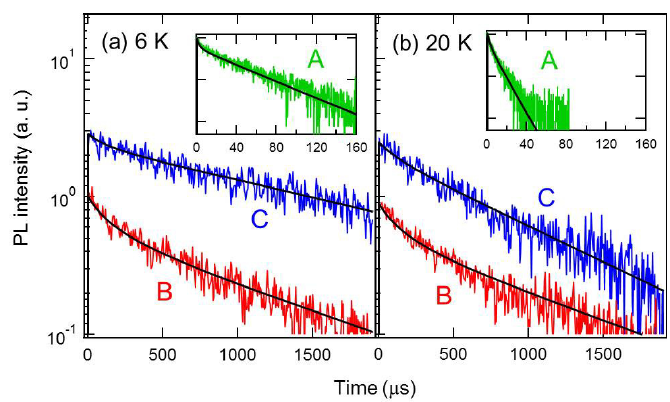
− Z (cid:48) Figure 5. Time-resolved-PL signals of the Y (cid:48) transition at ( a ) 6 K and ( b ) 20 K. Insets are the 1 1 logarithmic plots of PL intensities in Sample A. The signals of Sample B are shifted down for eye-friendly plots. The double exponential decays with characteristic relaxation times, τ fast and τ slow , are clearly observed for all the samples and temperatures. The solid curves are the calculations based on the population dynamics model in Section